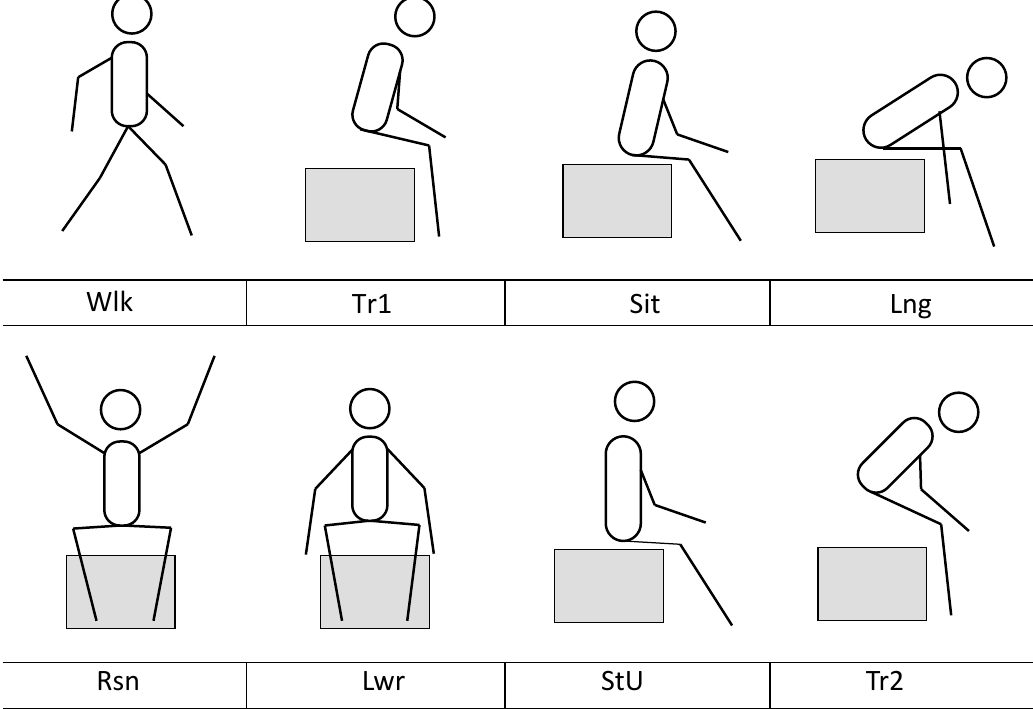
Figure 3. All eight classified